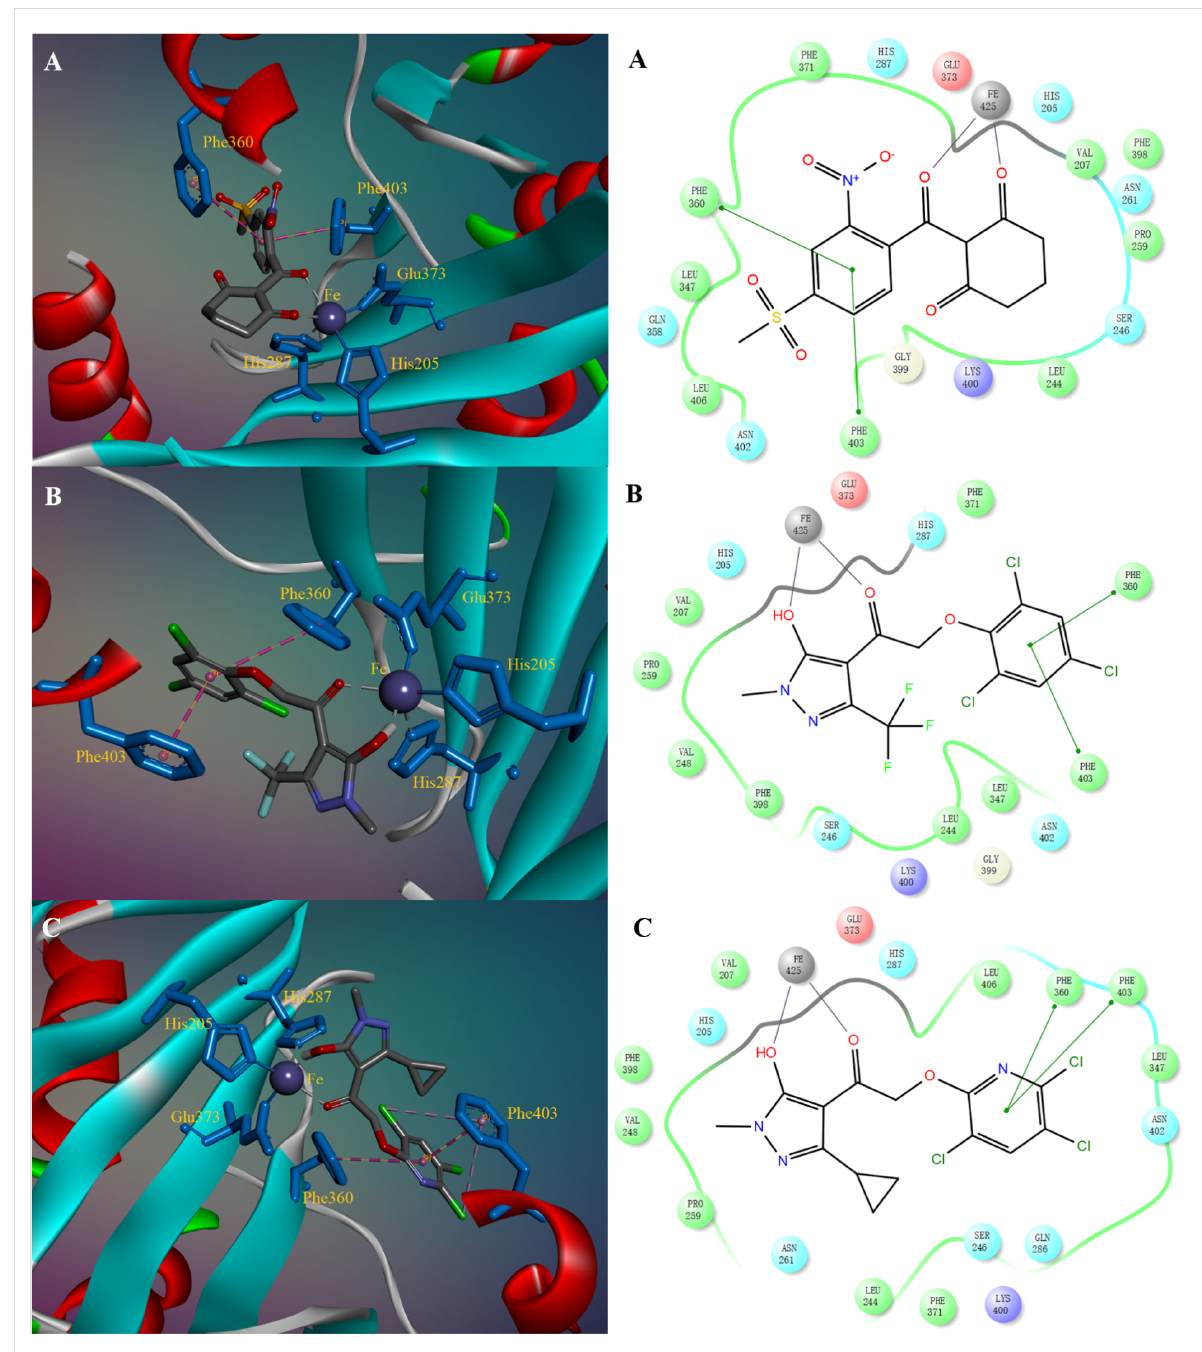
Figure 4: Simulated binding mode of mesotrione (A), compound I12 (B) and compound II4 (C) with At HPPD. The key residues in the active site are shown in blue sticks, and Fe II is shown as a dark blue sphere. mesotrione, compound I12, and II4 are shown in gray sticks.